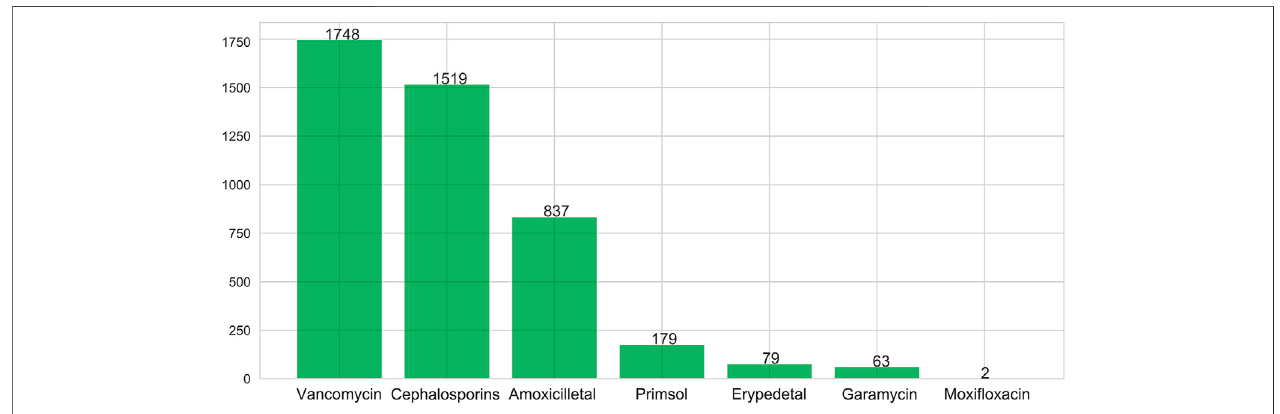
FIGURE 2 | Antibiotic used in patients with VAP.